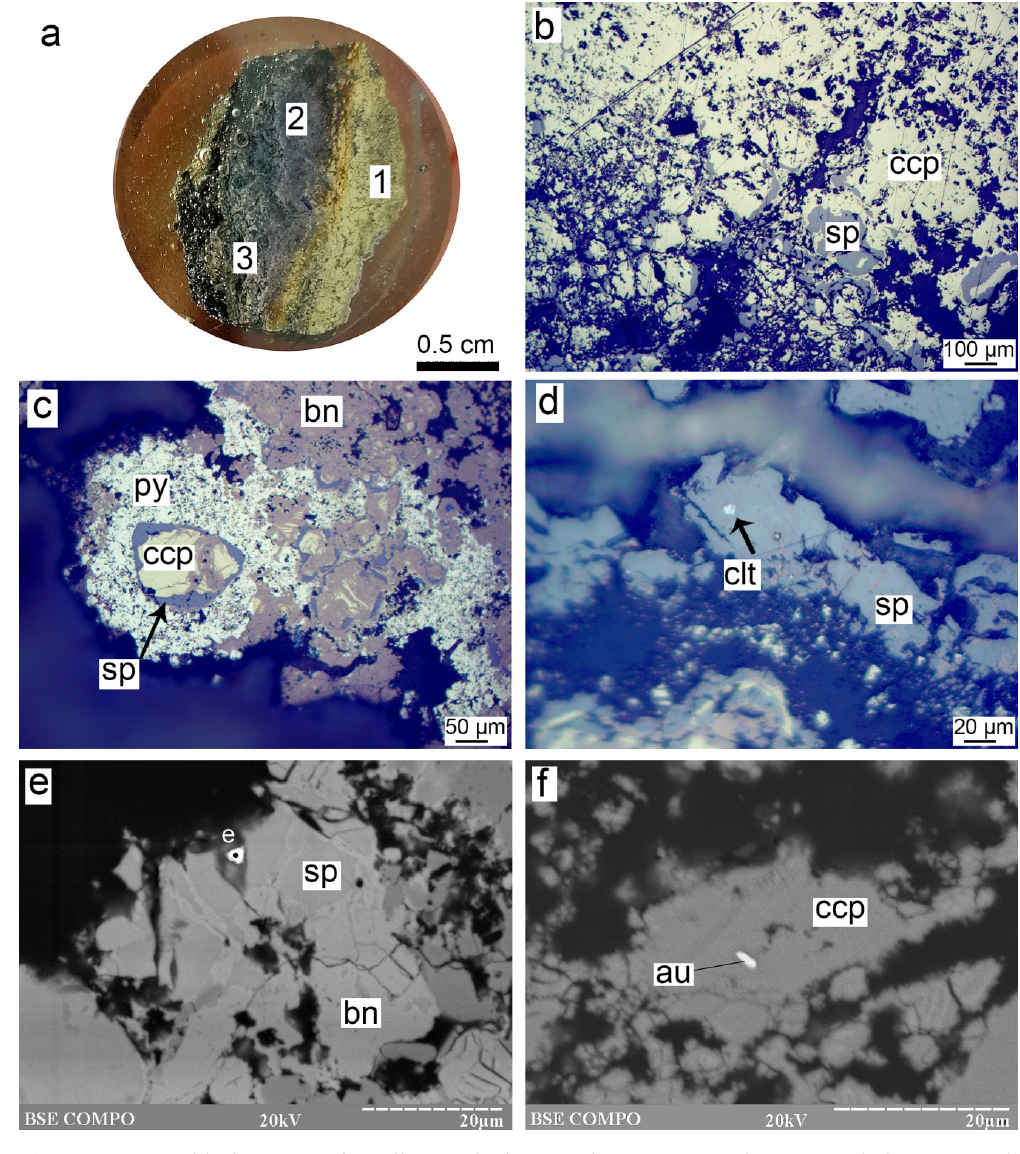
Figure 3. A possible fragment of small Cu-rich chimney from st. 240 with massive chalcopyrite-rich (1), massive bornite-rich (2), and porous bornite-rich (3) zones; ( a , polished section) massive chalcopyrite (ccp) of zone 1 overgrown by sphalerite (sp) ( b ); chalcopyrite crystals in zone 2 overgrown by sphalerite and fine-grained pyrite and replaced by bornite (bn) ( c ); clausthalite (clt) inclusion in sphalerite of zone 2 ( d ); galena grain (point e) in sphalerite replaced by bornite ( e ); native gold grain in chalcopyrite ( f ). Photos ( b – d ), reflected light; ( e , f ) SEM images. The inner zone (zone 1) ~5 mm thick is dominated by massive chalcopyrite aggregates, which are overgrown by sphalerite (Figure 3b). Toward the margin of the inner zone, one can observe individual well-formed chalcopyrite crystals, growing inward. Interstitions between massive chalcopyrite aggregates are filled with fine-grained (a few micrometers) chalcopyrite intergrowths. Sphalerite is characterized by a “chalcopyrite disease” (inclusions of ~1 μm and less) [31] and fine (~1 μm thick) chalcopyrite veinlets. The amount of sphalerite increases toward zone 2. Pyrite occurs in